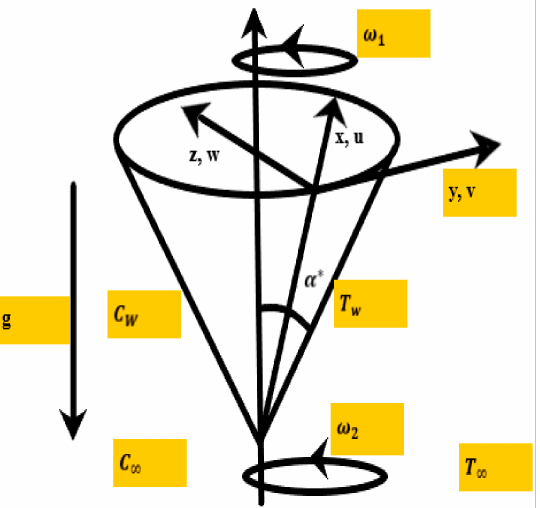
Figure 1. Physical physique and coordinates of the problem. u , v , w are components of velocity, T W , C W denotes temperature and concentration at wall, respectively. T ∞ , C ∞ are free stream temperature and concentration, respectively. ω 1 is cone’s rotation, ω 2 denotes fluid’s rotational velocity. g is gravitational force and α * describes angle of